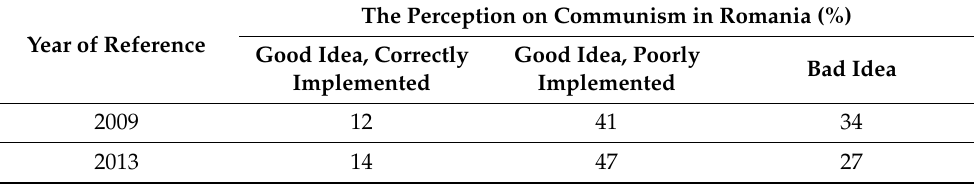
Table 1. The perception of communist ideology in post-revolutionary Romania [55]. The Perception on Communism in Romania Year of Reference